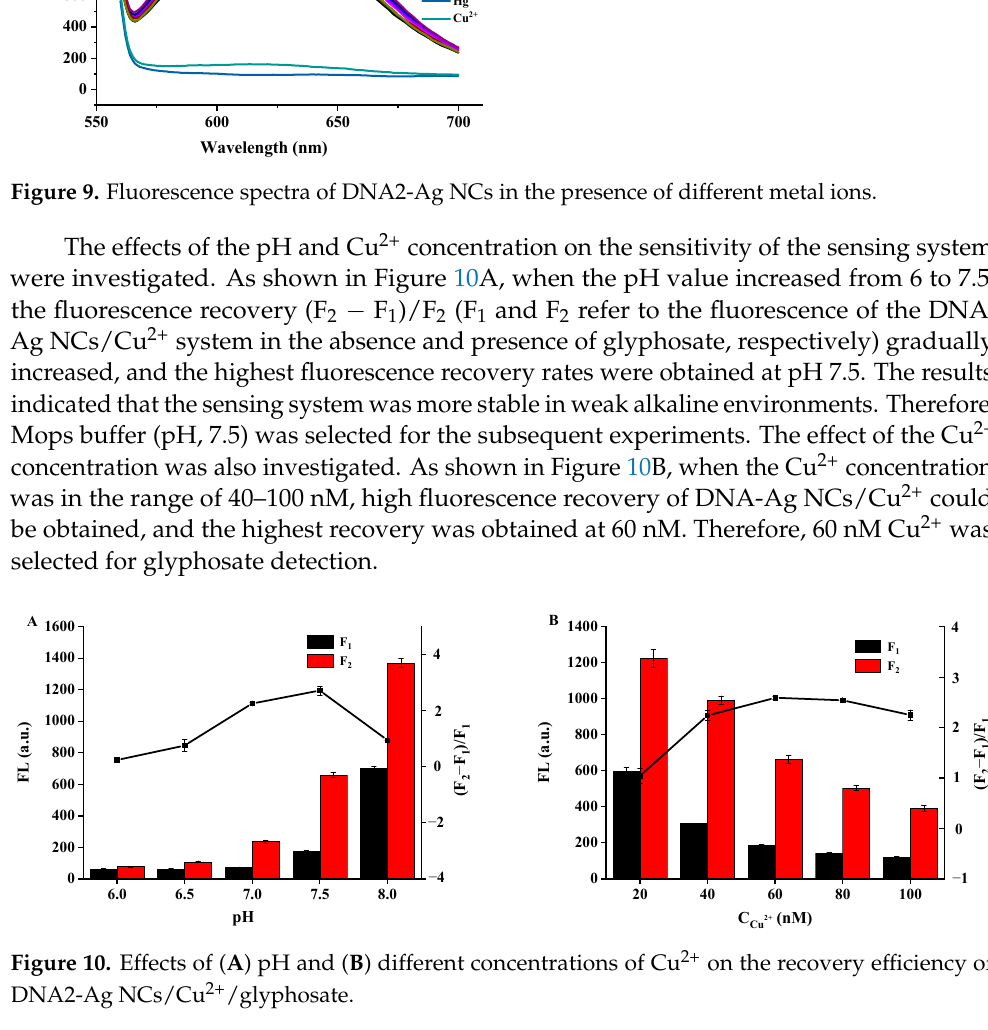
Figure 11. ( A ) The fluorescence recovery effect of DNA2-Ag NCs after adding different concentrations of glyphosate. ( B ) The relationship between the fluorescence intensity and different concentrations of glyphosate. Table 3. Comparison of different methods used for detecting glyphosate. Method